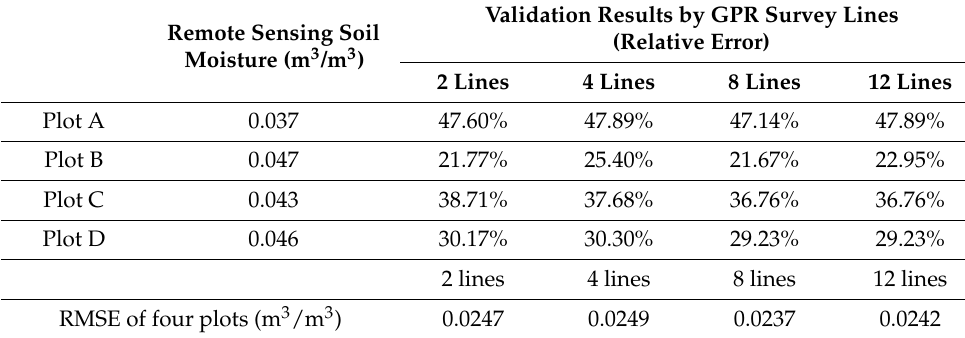
Table 5. Ground validation of remote sensing soil moisture by GPR survey